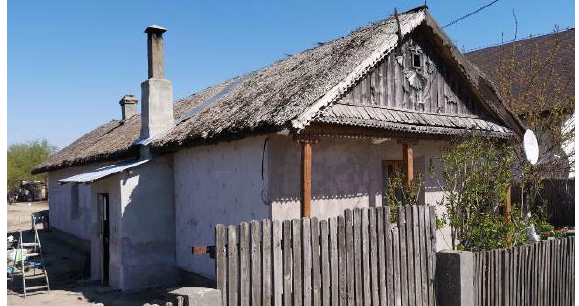
Figure 11. “Thermal rehabilitation” of an adobe house, in Sarichioi.